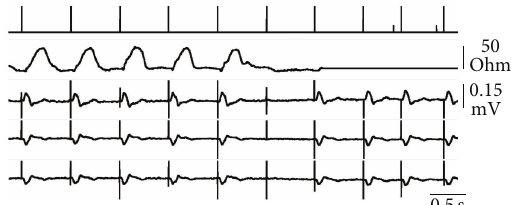
Figure 3: Real-time telemetry of event markers (1st tracing) and transvalvalvular impedance (2nd tracing) with simultaneous surface ECG recording (I, II, and aVR from the 3rd to bottom tracings, all with the same voltage scale) during ventricular threshold analysis in VDD. On the markers tracing, short bars represent atrial sensing, intermediate bars ventricular pacing, and the longest bars ventricular sensing in the pacemaker refractory period. From the 5th pulse onward the stimulation was below threshold and a narrow QRS replaced the pacing-evoked wide complex. Nevertheless, a properly timed TVI fluctuation was present, confirming the ejection occurrence, and the energy scan continued down to the minimum pulse amplitude